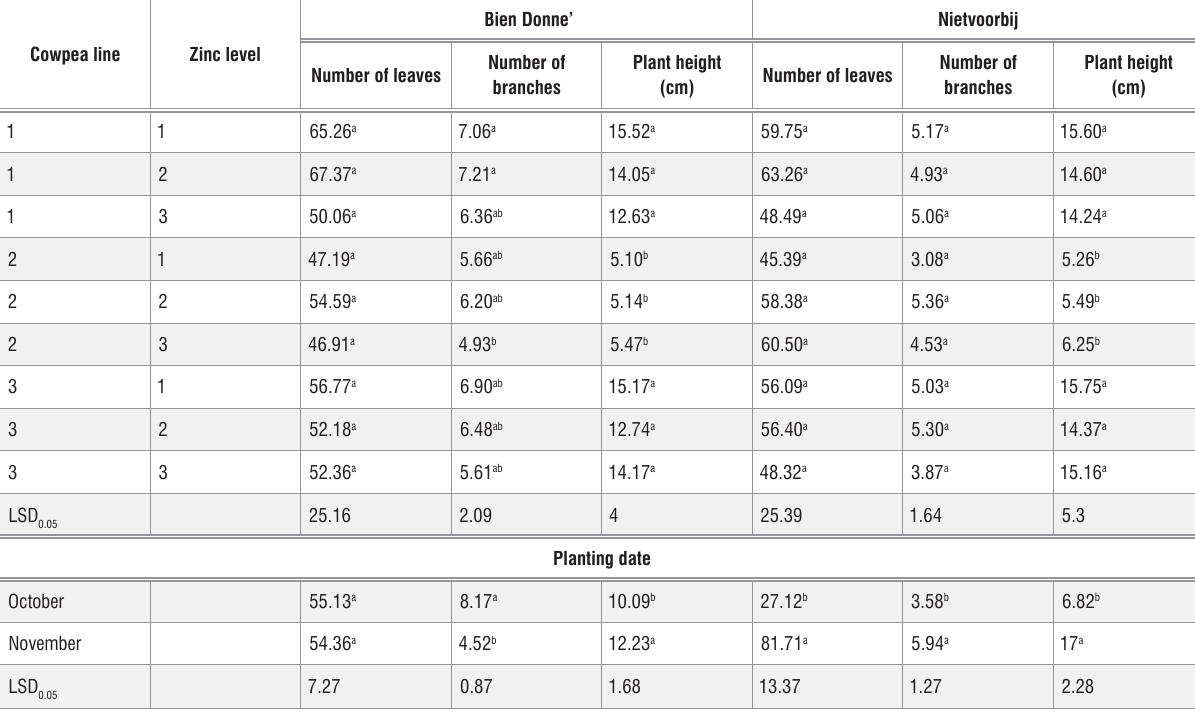
LSD , least significant difference; L1, Veg1; L2, M217; L3, Qukawa; T1, 0% Zn; T2, Zn at 50%; T3, Zn at 100%. 0.05 Means with different superscript letters within the same column are significantly different ( p